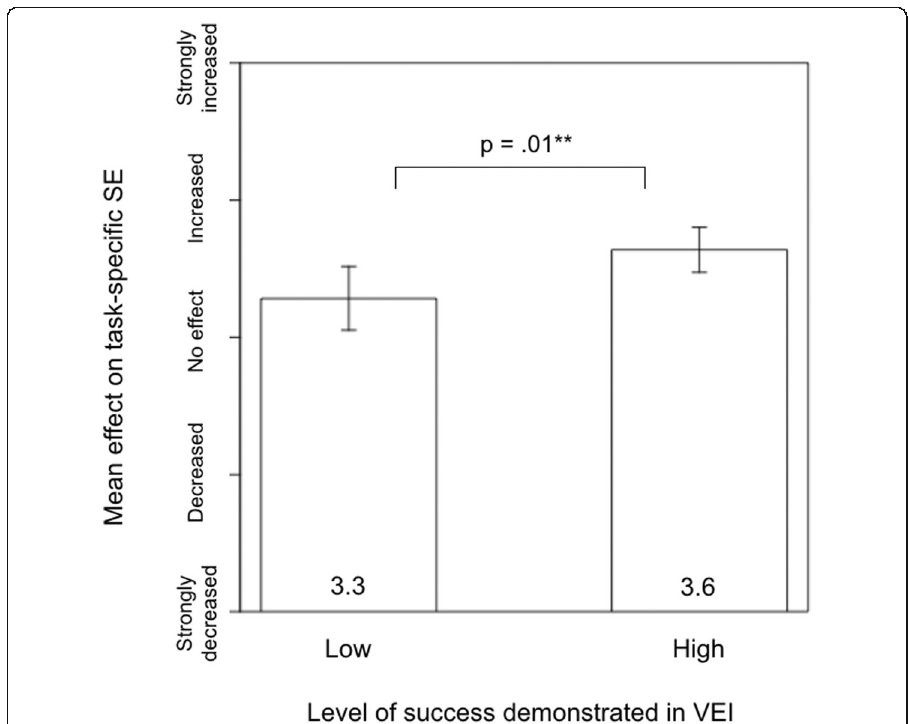
Fig. 7 Comparison of the mean effect on task-specific SE of VEI showing low and high levels of